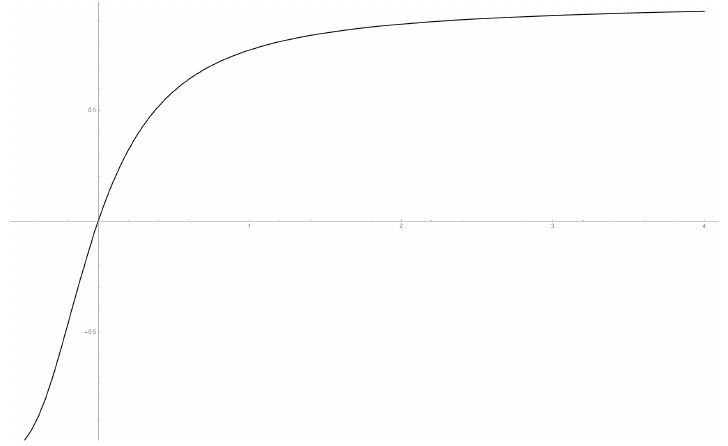
Figure 9. Function γ − 1 with a 1 on the x -axis, ρ on the y -axis; γ 1 is defined in Assumption 6. 1